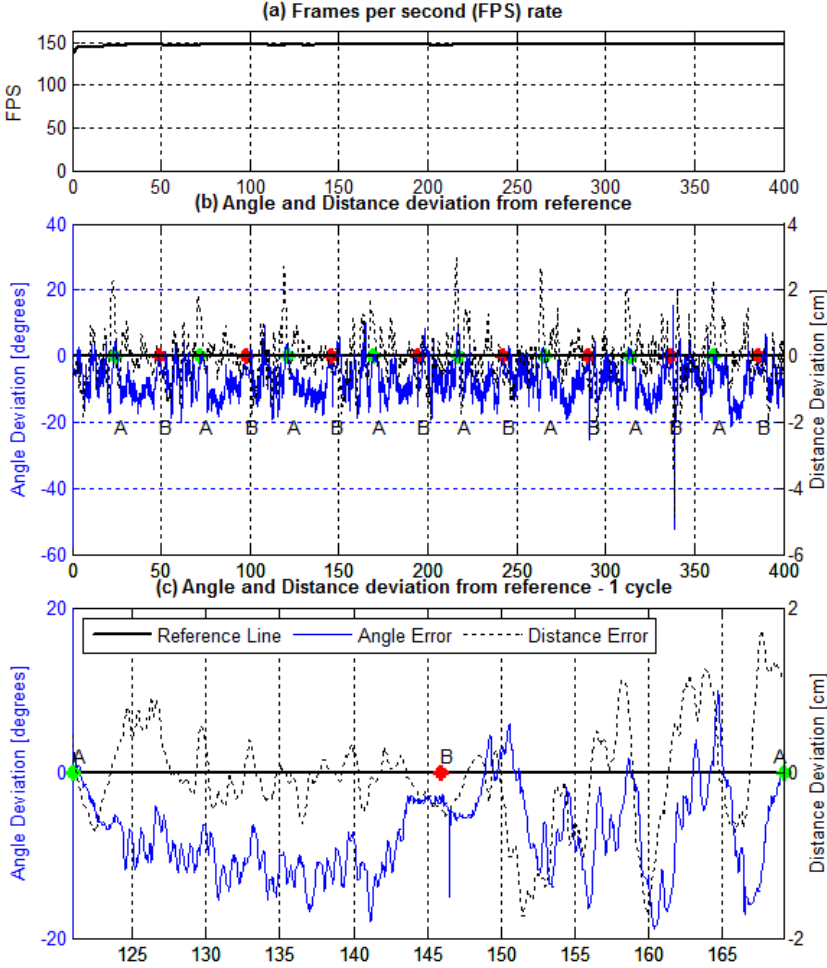
Figure 22. AGV line following the trial on the eight-shaped lane, eight complete laps, with rectangular kernel of 30 × 10 size. ( a ) frames per second rate during the trial; ( b ) total trial data for angle and distance measurements; ( c ) a single cycle